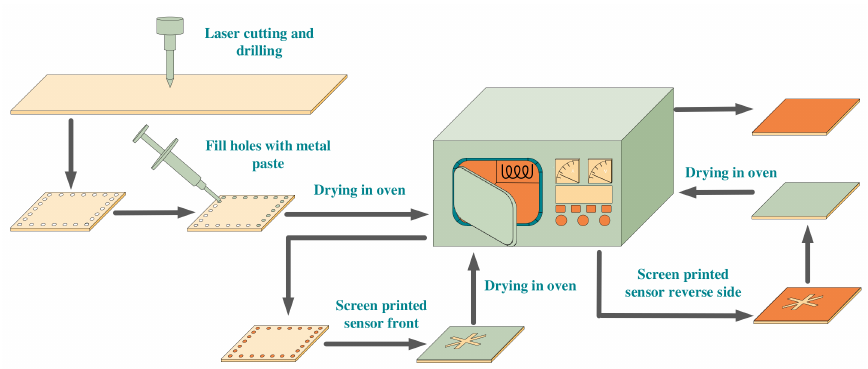
Figure 6. The production process of the sensor.